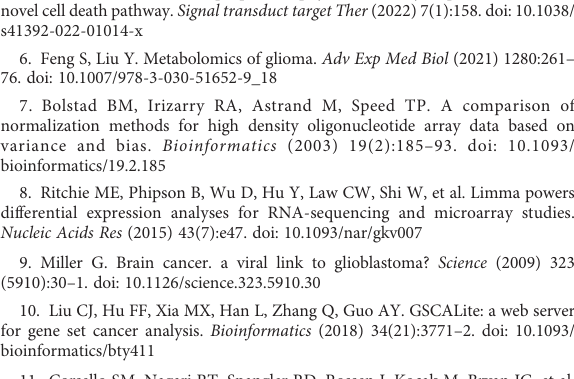
SUPPLEMENTARY TABLE 2 List of the fi ve cuproptosis-associated risk signature genes and their corresponding regression coef fi cients.